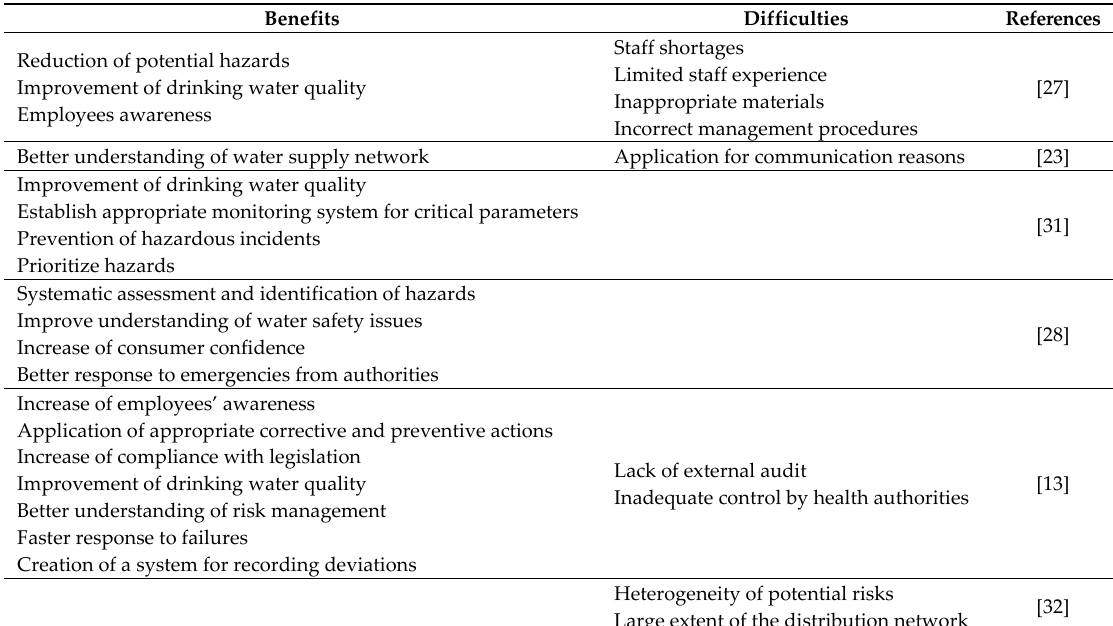
Table 1. The main benefits and difficulties of HACCP implementation in European water